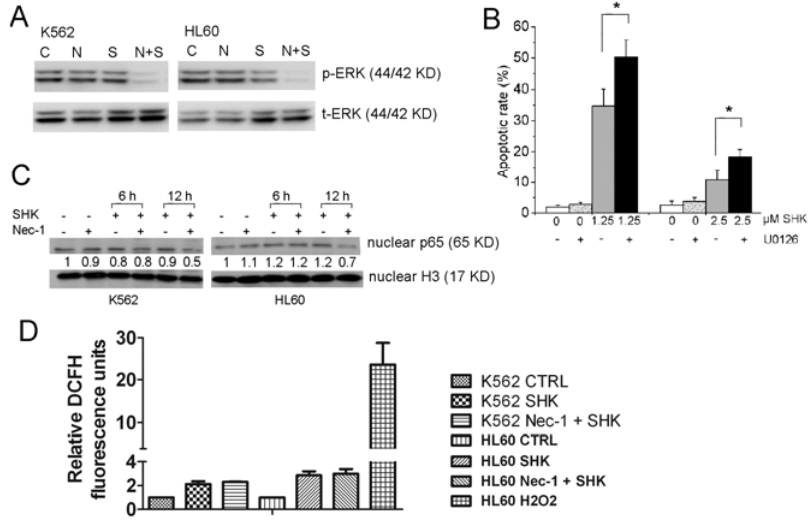
Figure 5. ERK1/2, but not NF- κ B and ROS are involved in the Nec-1 enhancement of apoptosis. ( A ) HL60 and K562 cells were treated with shikonin in the absence or presence of Nec-1 for 12 h. The phosphorylation of ERK1/2 was detected by Western blot; ( B ) Cells were treated with SHK for 12 h in the presence or absence of 5 μ M U0126. The apoptotic rate was measured as described in Materials and Methods; ( C ) HL60 and K562 cells were treated with shikonin in the absence or presence of Nec-1 for 0, 6 or 12 h. NF- κ B activation was detected by Western blotting. Histone H3 served as an internal control of nuclear protein. Protein ratios were calculated following ImageJ densitometric analysis; ( D ) K562 and HL60 cells were treated with shikonin in the absence or presence of Nec-1 for 3 h and assayed for ROS using DCFH-DA. HL60 cells treated with 30% H used as a positive control. Relative DCFH fluorescence units were calculated from fluorescence mean compared to the control group. Data are mean ± SD or representative of at least three independent experiments, and analyzed by Student’s t test. * p < 0.05 compared with SHK treated